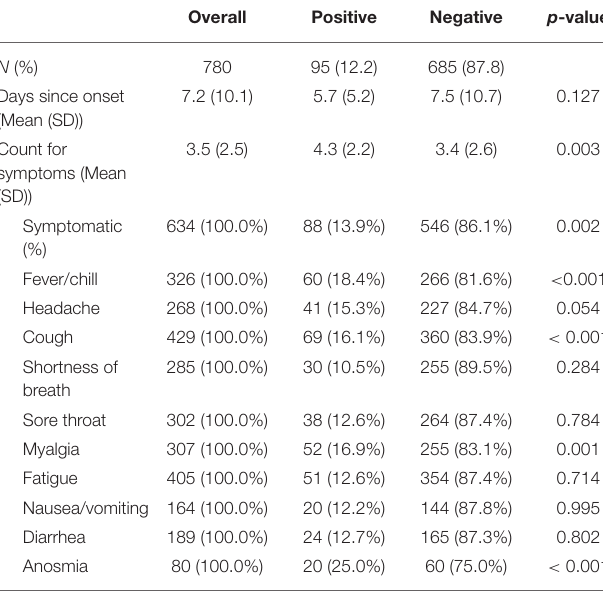
TABLE 2 | Clinical characteristics and symptoms reported by individuals in the study population during clinical intake, stratified by SARS-CoV-2 RT-PCR assay results a